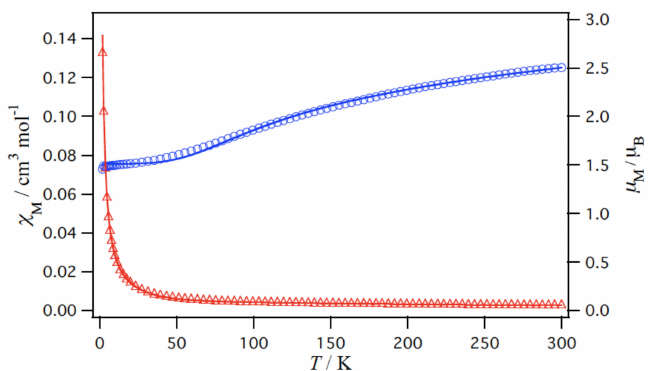
Figure 7. Temperature dependence of magnetic susceptibility χ M ( ∆ ) and magnetic moment µ eff ( ◦ ) of [Cu 3 ( L 9 ) 2 ( µ -OCH 3 ) 2 ] ( 9